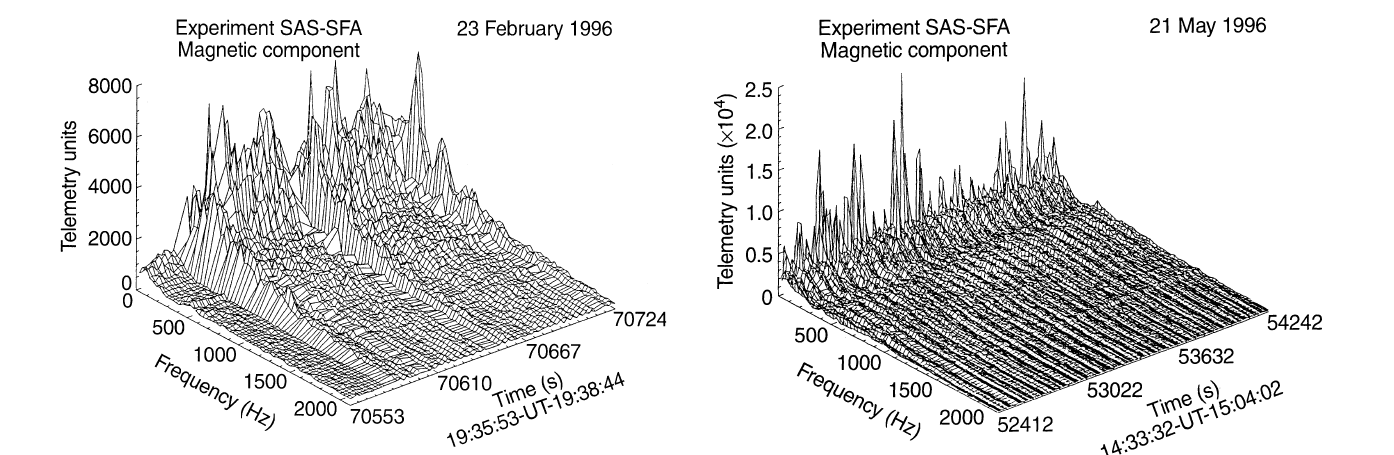
Fig. 2. A panoramic view of the magnetic-field ( B fluctuation spectra in the frequency range 32–2000 Hz taken within the plasma sheet on 23 February 1996 during disturbed time ( K p (cid:136) 3). Horizontal axes represent frequency and universal time, the vertical spectral density in the telemetric units. The co-ordinates: geocentric distance, magnetic local time and magnetic latitude of the satellite during the time-interval of the measurements are 10.5 R The increase in intensity just above 250 and 500 Hz at 19:37 UT and at the end of the interval of the measurements is associated with harmonics of the electron cyclotron frequency